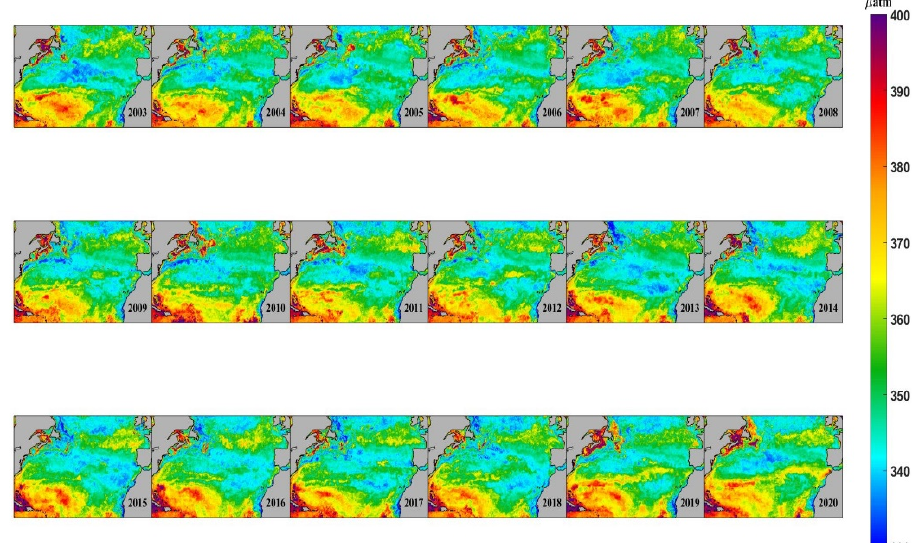
Figure 6. Annual mean distribution of sea surface pCO 2 from 2003 to 2020.